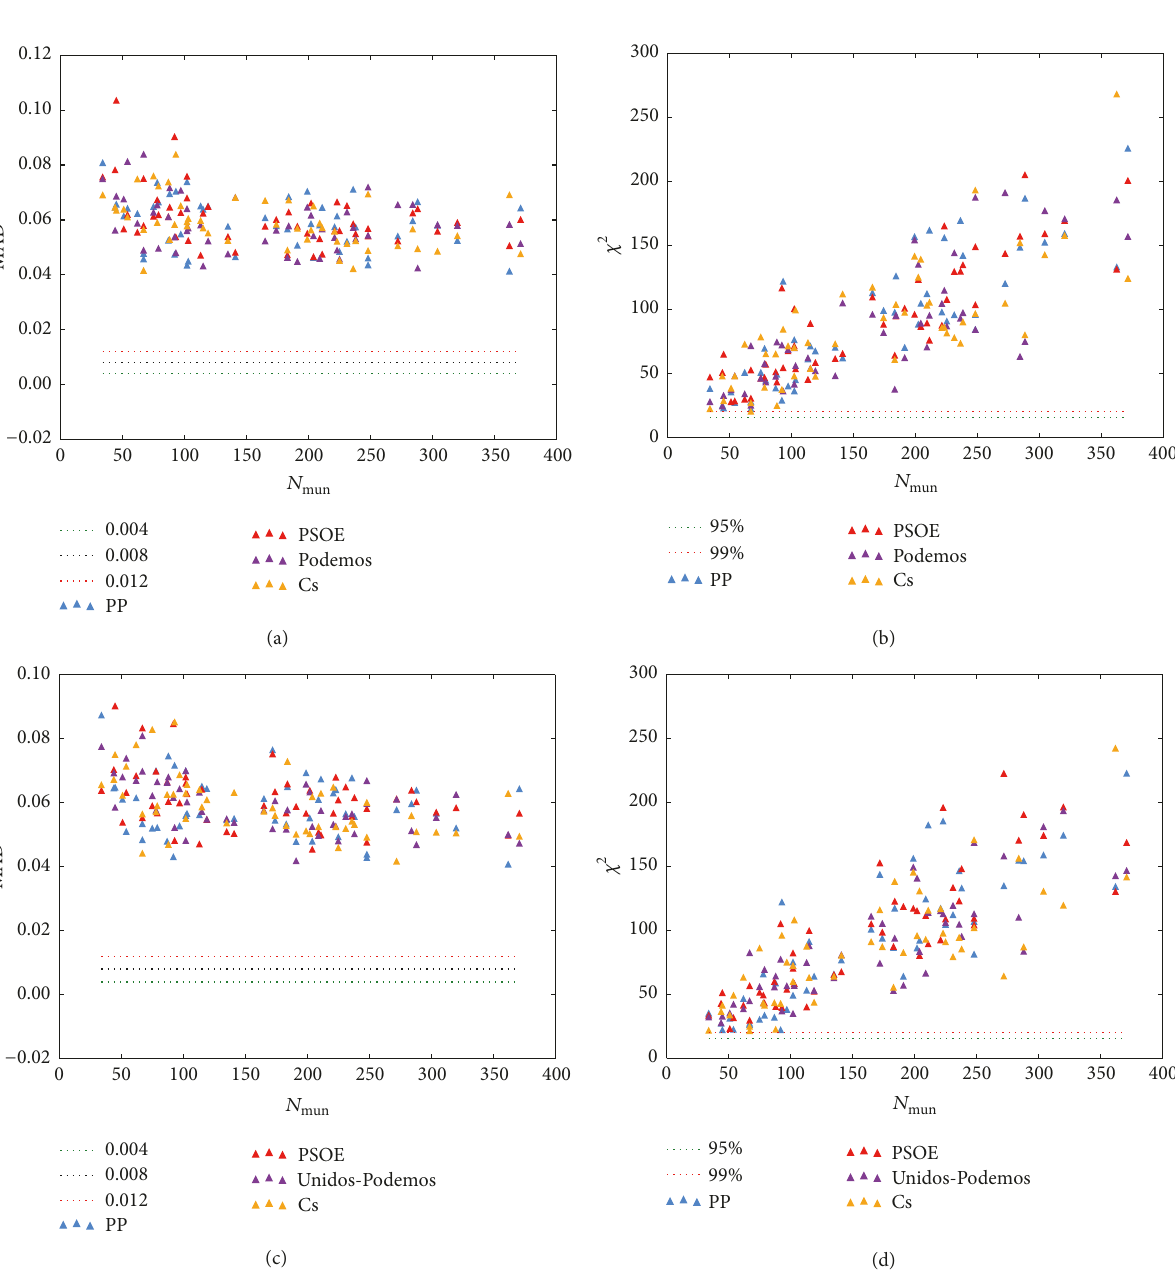
Figure 12: Scatter plot of the MAD (a, c) and 𝜒 2 (b, d) statistics extracted from the 2BL test of each precinct as a function of the number of municipalities in each precinct (2015 results are shown in (a, b) and 2016 ones are shown in (c, d), with no obvious differences). In the case of MAD, we find a weak negative correlation as expected, but this correlation is not enough to explain the systematic nonconformance to 2BL. In the case of 𝜒 2 , the effect is quite the opposite, and nonconformance is stronger as the size of the precinct increases, thereby suggesting that nonconformance to 2BL at this level of aggregation is a genuine result and not a spurious effect of finite size